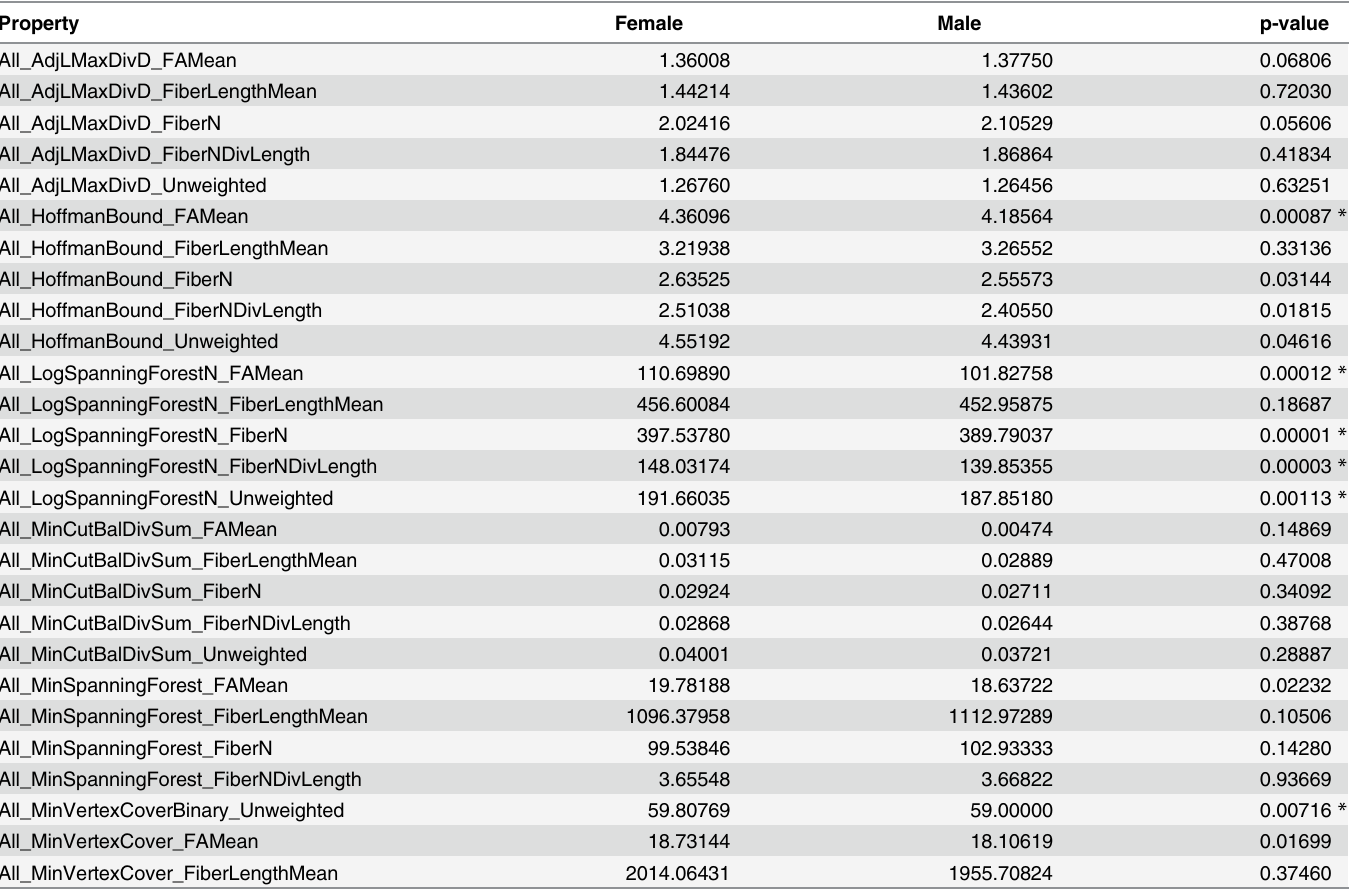
Table 2. The graph-theoretic parameters computed for the 83-vertex graphs. The table contains their arithmetic means in the male and female groups, and the corresponding p-values in round 1 (see the “ Statistical analysis ” subsection). The results of the graph-parameters are defined in the caption of Table 1. Significant differences ( p < 0.01) are denoted with an asterisk in the last column.